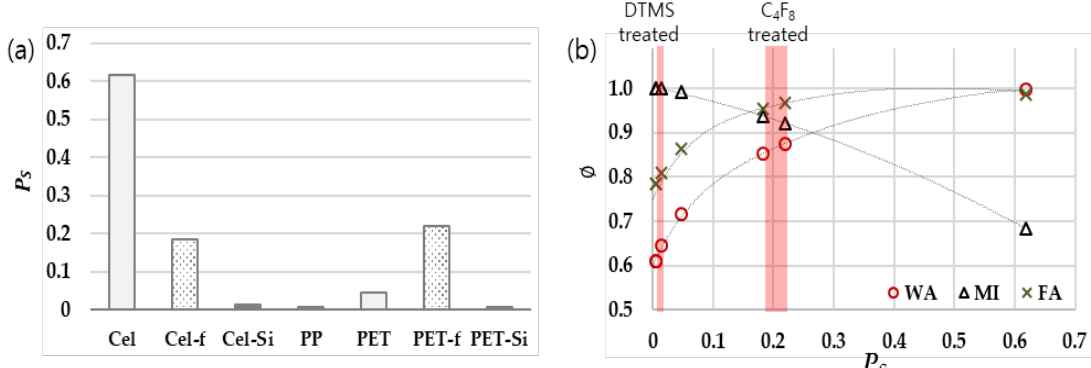
Figure 2. Wettability with different surface energy surfaces. ( a ) cosθ with different Φ √𝛾 𝑆 ; ( b ) cosθ with different γ S .